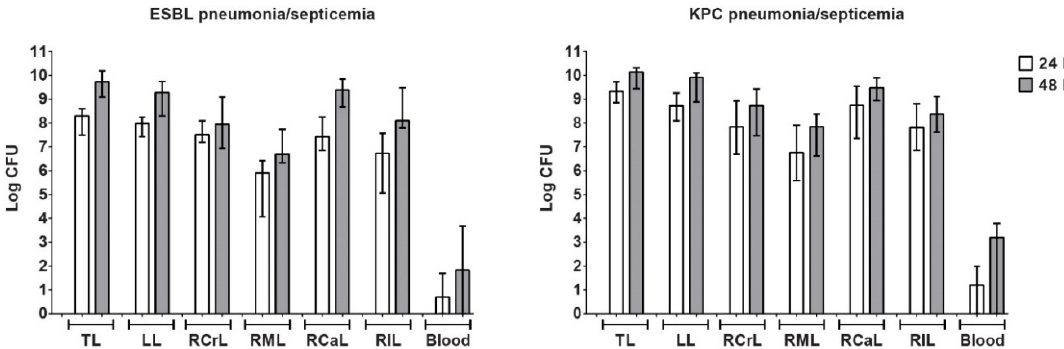
Figure 2. Bacterial load of K. pneumoniae in lungs and blood of rats with K. pneumoniae pneumonia–septicemia in the early phase of infection. Bacterial load of K. pneumoniae was determined for total lungs and individual lung lobes and blood (per mL) of rats with K. pneumoniae ESBL pneumonia–septicemia and rats with K. pneumoniae KPC pneumonia–septicemia at 24 h and 48 h after initiation of infection. TL, total lungs; LL, left lobe; RCrL, right cranial lobe; RML, right middle lobe; RCaL, right caudal lobe; RIL, right intermediate lobules. Groups of 6 rats per time point. Bacterial load is expressed as log CFU (median ± range).